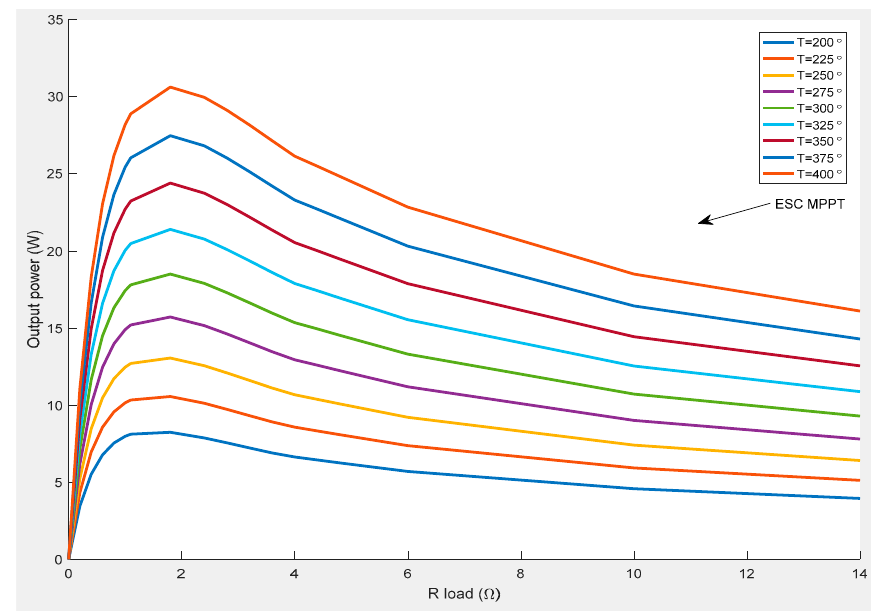
Figure 12. The output power of the ESC based model for a single TEG.